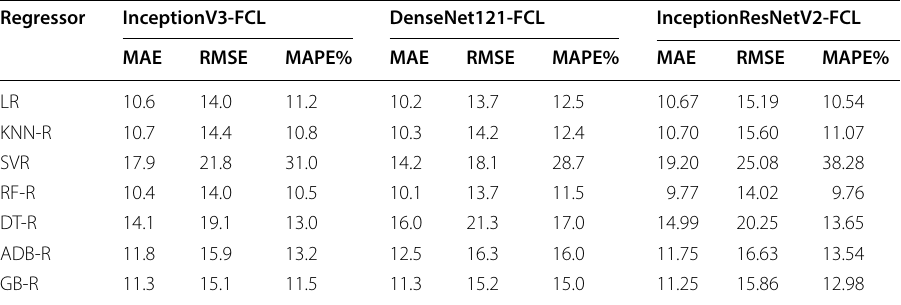
Table 2 Result of single Feature Connected Layer output (FCL) for digital hand altlas dataset